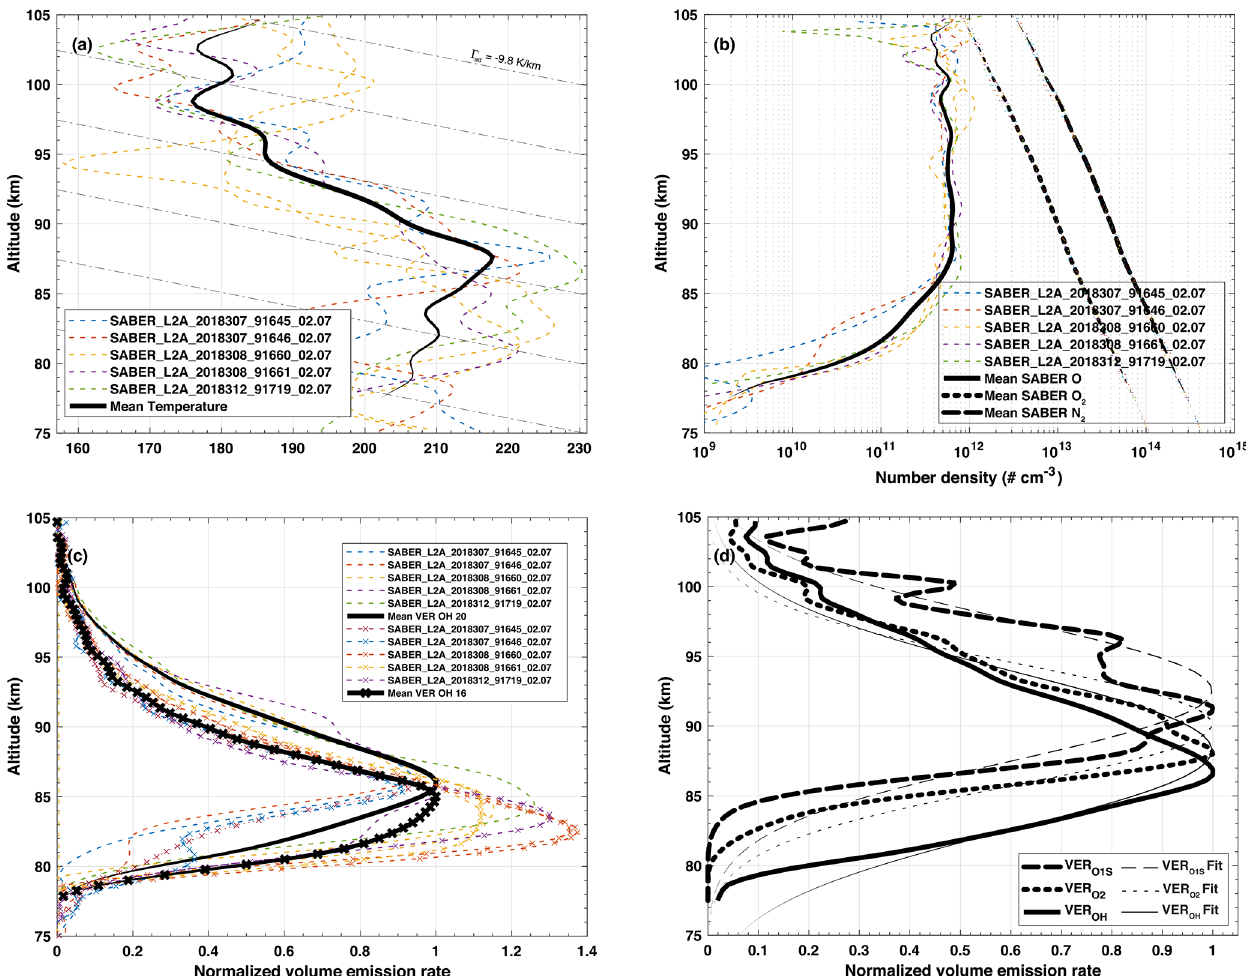
Figure 4. (a) Temperature, (b) atomic oxygen, molecular oxygen, molecular nitrogen number densities, and (c) OH20 (2.1µm OH(A)) and OH16 (1.6µm OH(B)) volume emission rates collected by TIMED/SABER satellite near Kühlungsborn during the SIMONe–2018 campaign within 4 ◦ of latitude or longitude of the observatory. (d) Calculated volume emission rates for OH(8,3), O 2 (0,1), and O( 1 S) layers (thick black lines) using SABER mean profiles in panels (a) and (b) . Colored dotted lines in (a) , (b) , and (c) indicate individual orbits of the satellite, while thick lines indicate the mean of the individual orbits. Gray dash–dot lines in (a) indicate the adiabatic lapse rate (cid:48) ad =− 9.8Kkm − 1 . Thinner black lines in (d) are Gaussian fits of the calculated VER profiles. Individual VER airglow layer features for both measured and calculated VER are in Table 2. We have used SABER data version 2.07 to compose these